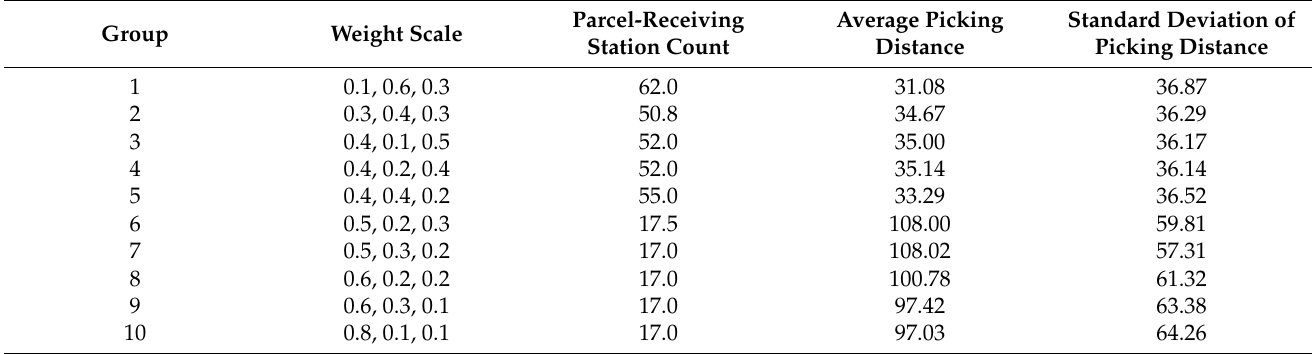
Figure 14. Cost of different upper-layer model-weight combinations. ( a ) Selected parcel-receiving station count. ( b ) Average picking distance. ( c ) Picking fairness. Table 9. Pareto optimal solution with different weight